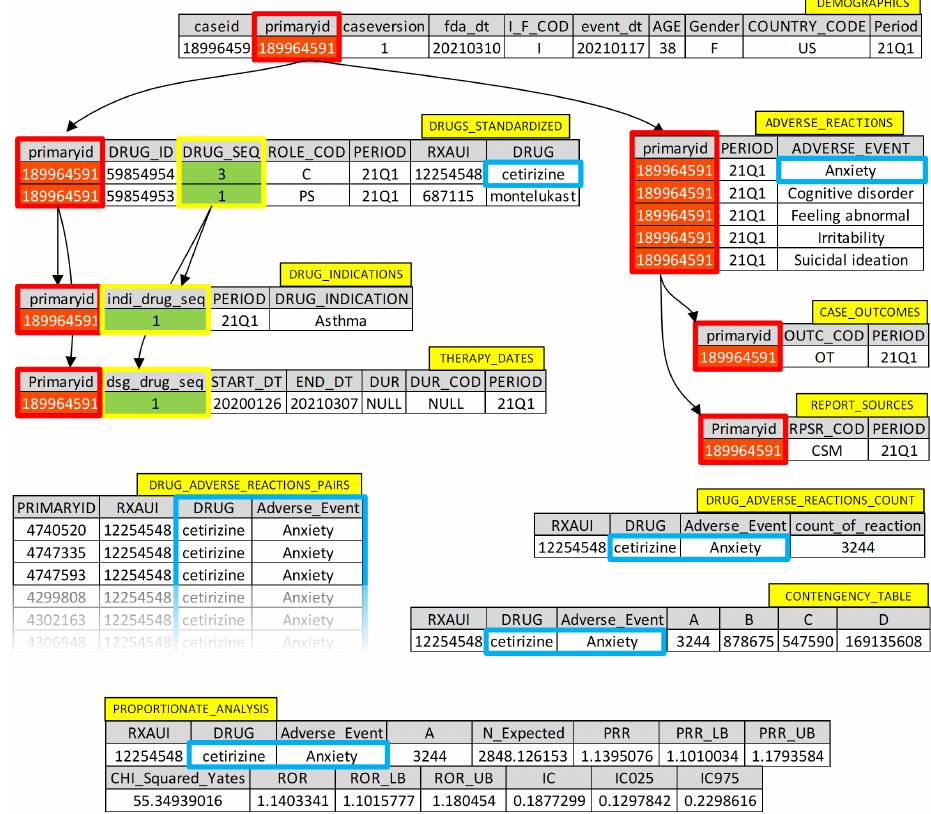
Figure 3. Detailed example of data retrieval from the dataset.